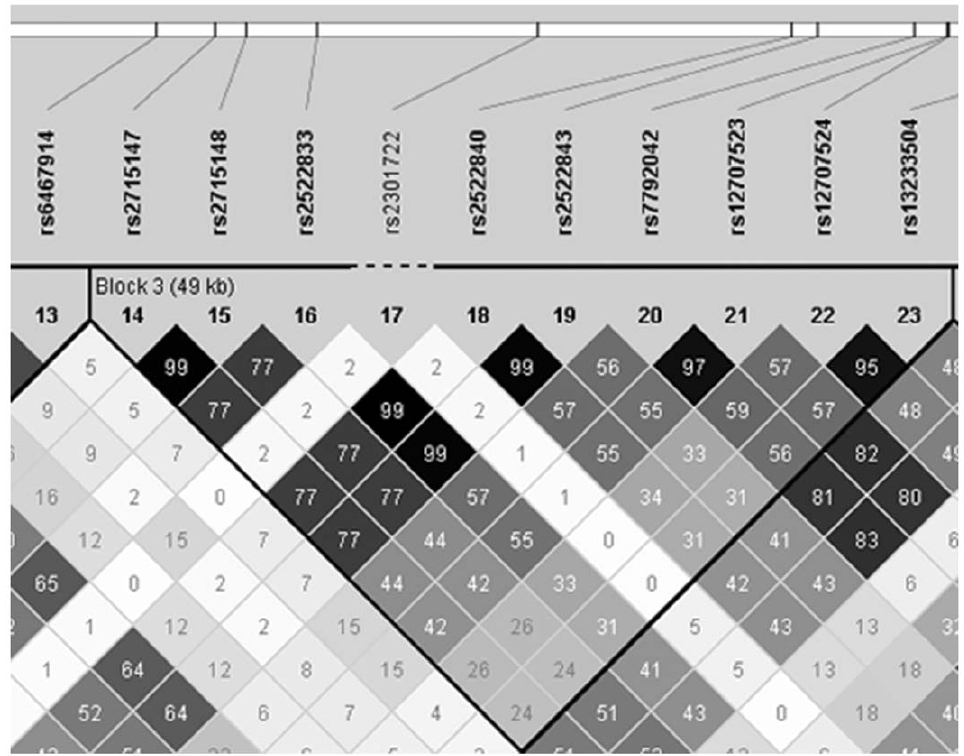
Figure 2. The LD-structure of PCLO . The LD-structure of PCLO shown in an r 2 -plot created in Haploview. The plot shows the LD-block in which the SNPs with the lowest P-values were found. Non-synonymous coding SNP rs2522833, rs2715147 and rs2715148 are in high r 2 with each other.